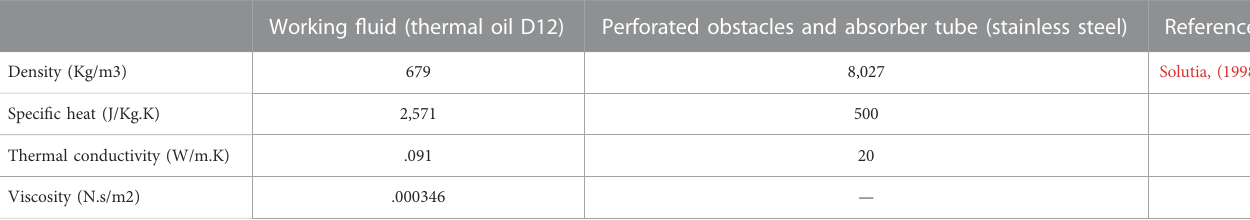
TABLE 2 Thermophysical properties of the working fl uid, perforated obstacles, and absorber tube.